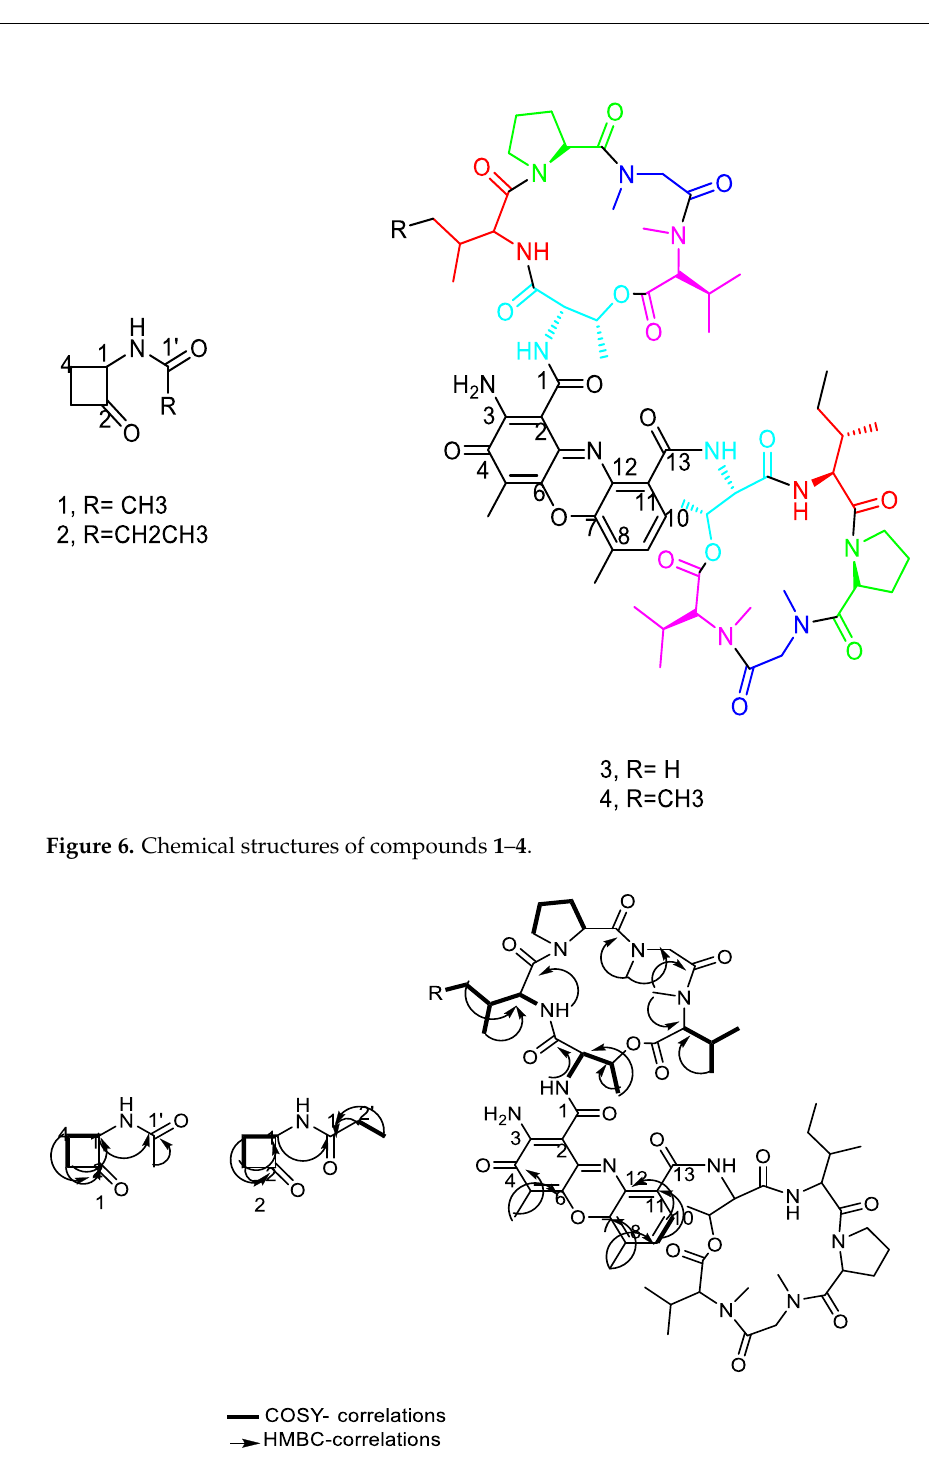
Figure 7. COSY and HMBC correlations of compounds 1 – 4 .